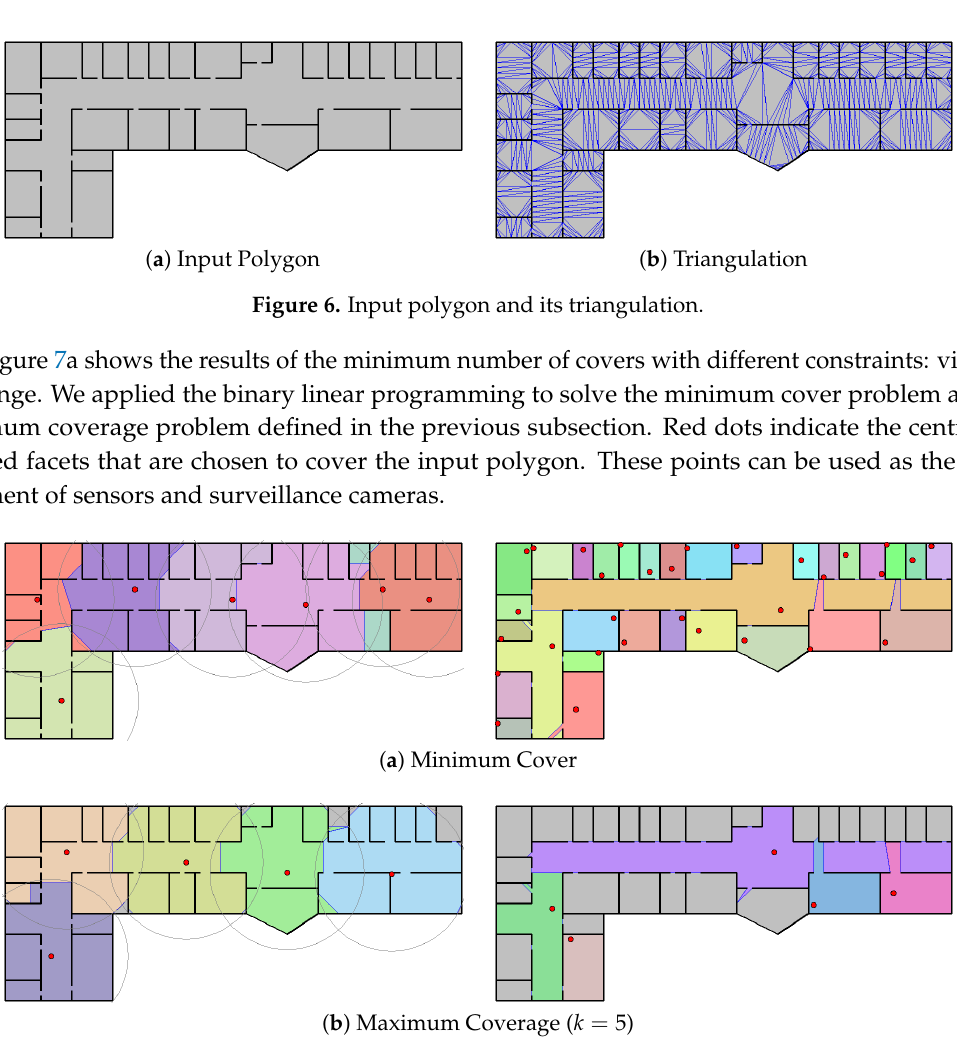
Figure 7. Results of ( a ) minimum cover with different constraints, and ( b ) maximum coverage with different constraints ( k = 5) with (left) range and (right) visibility